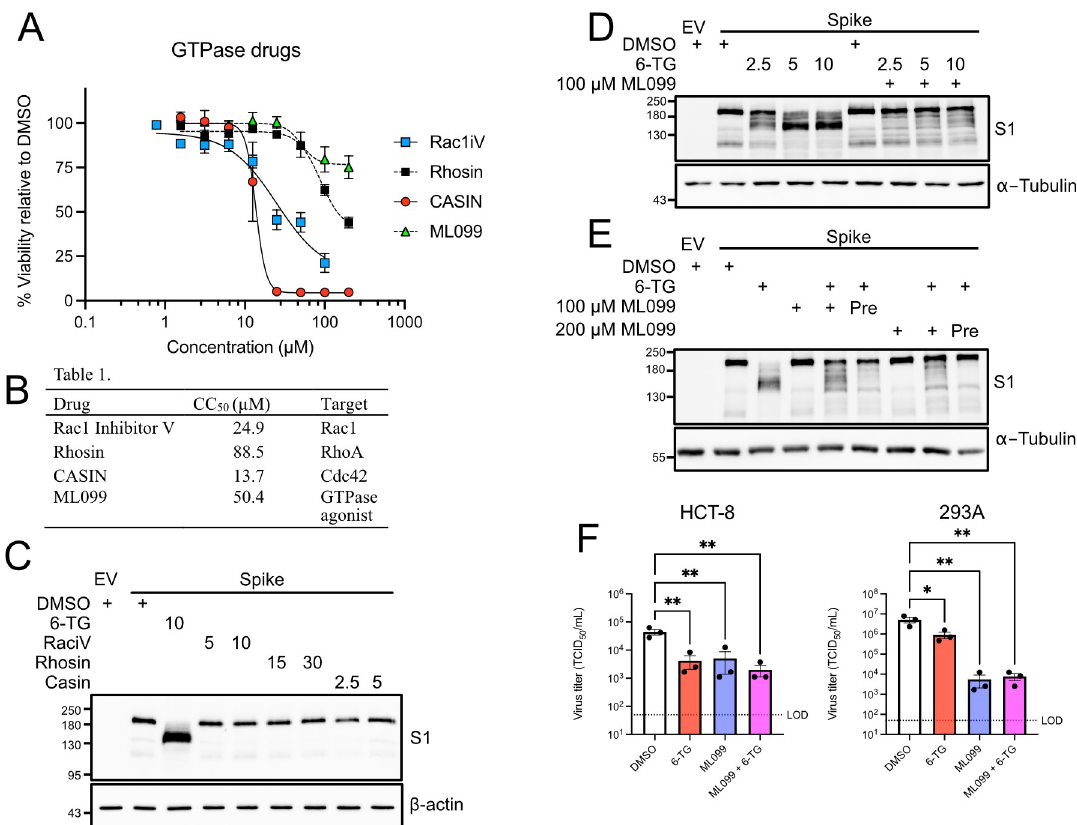
Fig 7. 6-TG inhibits Spike maturation through GTPase inhibition. (A) AlamarBlue cell viability assay of 293T cells treated Rac1 Inhibitor V (Rac1iV), Rhosin, CASIN, or ML099 (n = 3 ± SEM). (B) Summary table of 50% cytotoxic concentration (CC 50 ) and inhibitor target of compounds tested in (A). (C) 293T cells were transfected with SARS-CoV-2 Spike vector or an empty vector control (EV) then treated with 6-TG, GTPase inhibitors, or DMSO vehicle control. Concentrations in legend are in μ M. Lysates were harvested 24 h after transfection and were probed by western blotting as indicated. (D) 293T cells were transfected with plasmids encoding SARS-CoV-2 Spike or EV control then co-treated with 6-TG, 100 μ M ML099 GTPase agonist, or DMSO. Lysates were harvested 24 h after transfection and were probed by western blotting as indicated. Concentrations in legend are in μ M. (E) as in (D) except some samples were pre-treated (Pre) for 4 h with ML099. (F) HCT-8 and 293A were infected with an MOI of ~0.1 then treated with 10 μ M 6-TG and/ or 100 μ M ML099 or DMSO vehicle control. After 24 h, the supernatants were harvested and stored at -80˚C until titering on BHK-21 (n = 3 ± SEM, statistical significance was determined by one-way ANOVA; � , p < 0.05; �� , p < 0.01; ns, non-significant). LOD = Limit of Detection for virus